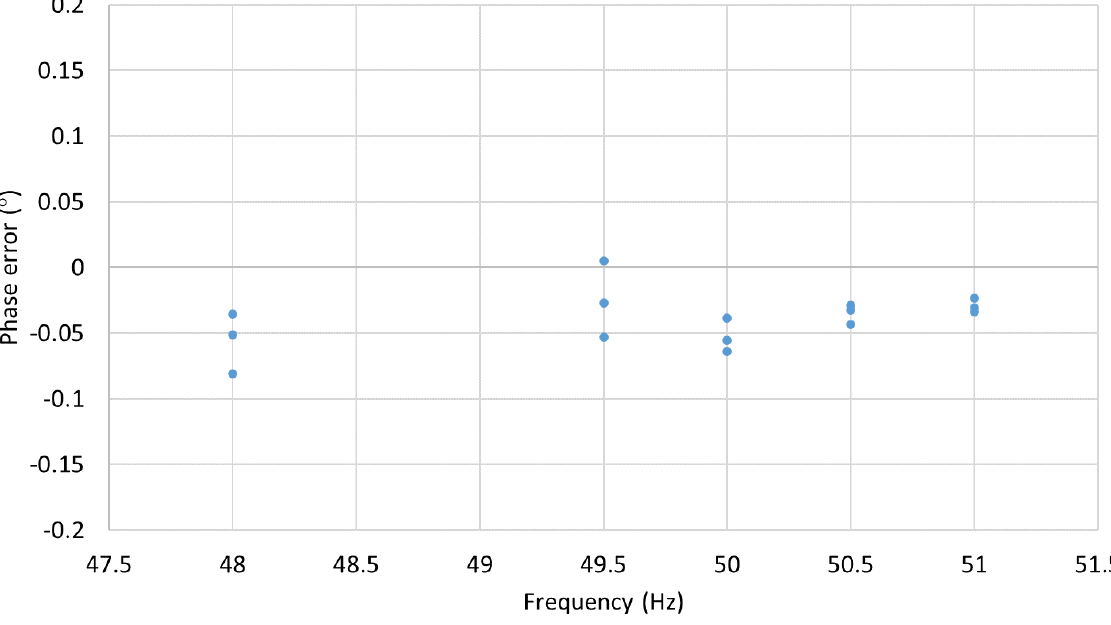
Figure 11. MVT phase errors at nominal voltage and frequencies 48, 49.5, 50.5, 51 Hz.